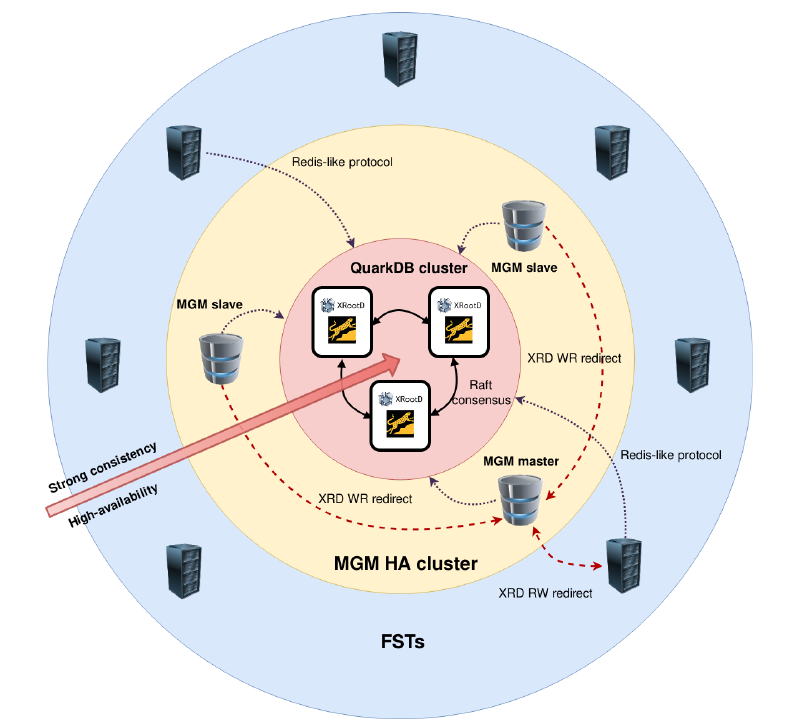
Figure 1. A schematic diagram of the EOS